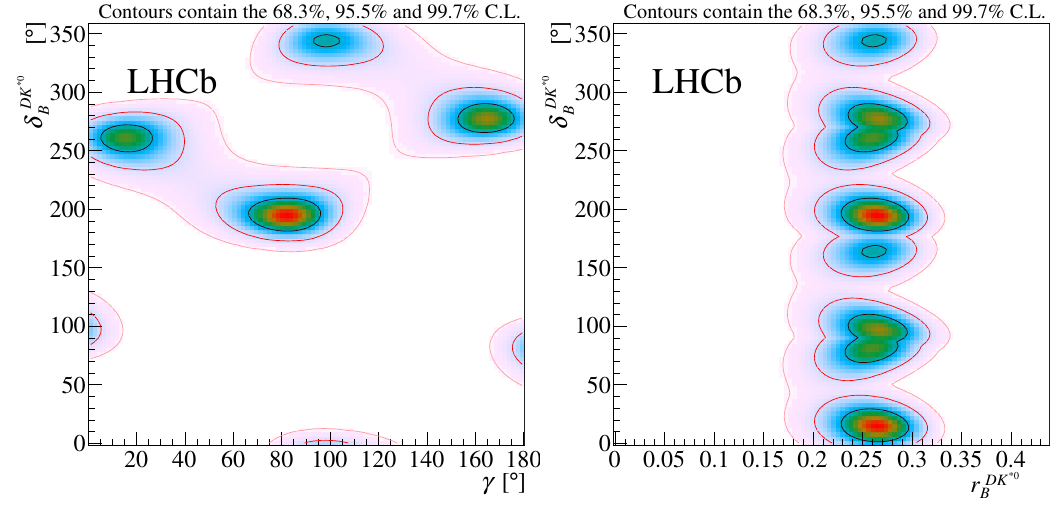
Figure 6 . Contour plots showing 2D scans of (left) (cid:14) DK (cid:3) 0 The lines represent the (cid:1) (cid:31) 2 = 2.30, 6.18 and 11.8 contours, corresponding to 68.6%, 95.5% and 99.7% con(cid:12)dence levels (C.L.),